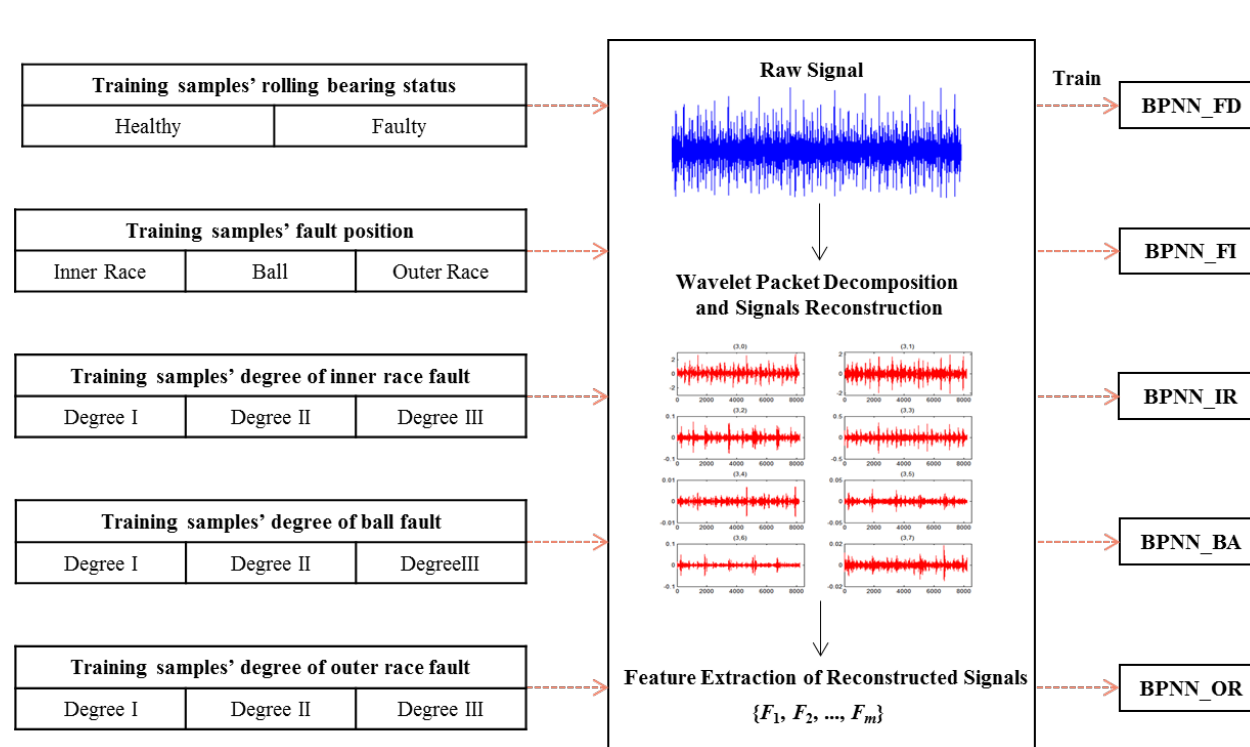
Figure 4. Training process of the hierarchical decision fusion fault diagnosis method.